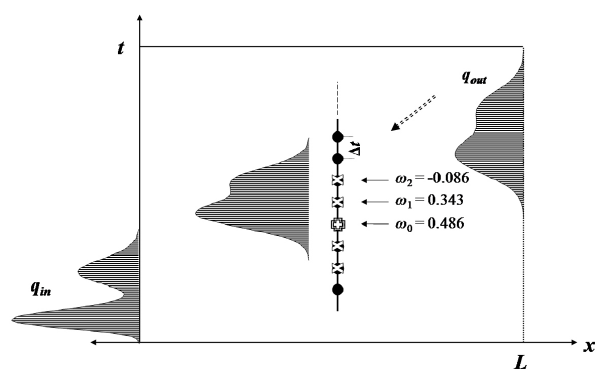
Fig. 7. Concept of reverse routing with filtering with the sym- metric, second order, five-point Savitzky-Golay low-pass filter; weights: ω 0 = 0 . 486, ω − 1 = ω 1 = 0 . 343, ω − 2 = ω 2 =− 0 . 086.